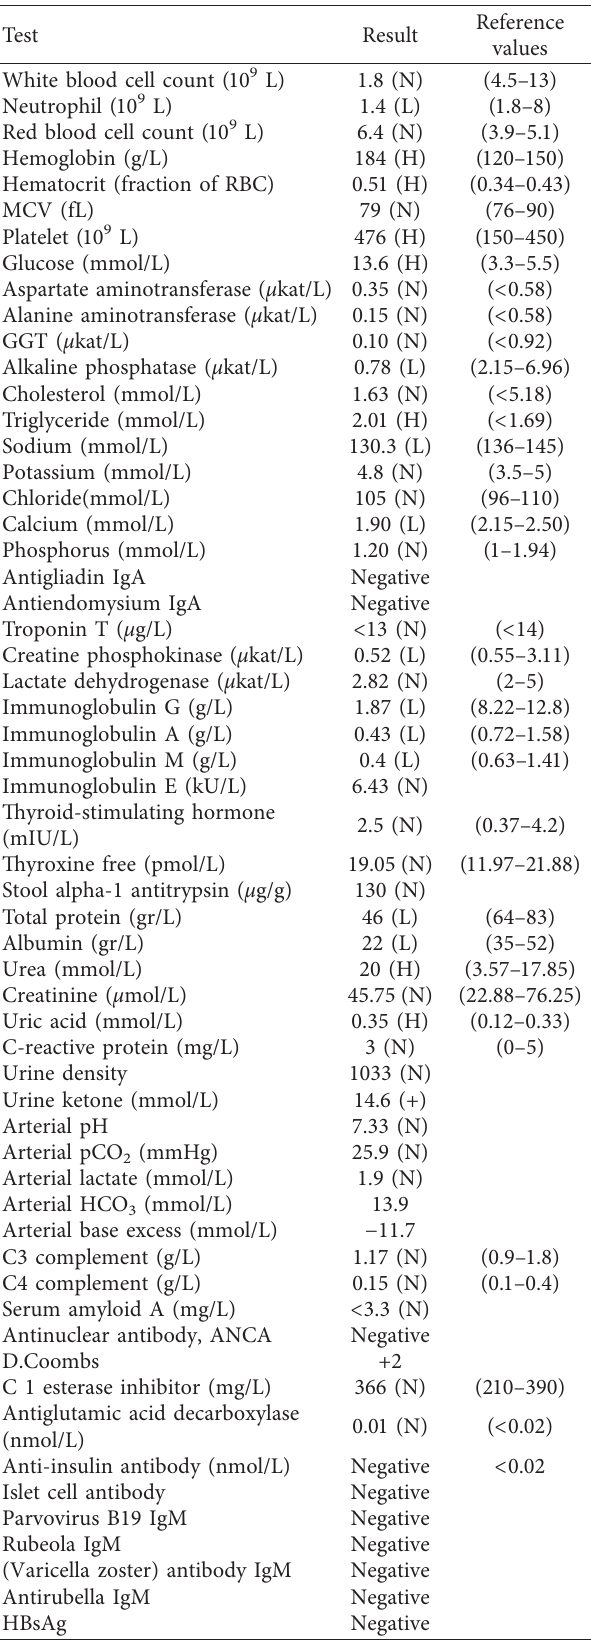
Table 1: Laboratory parameters on